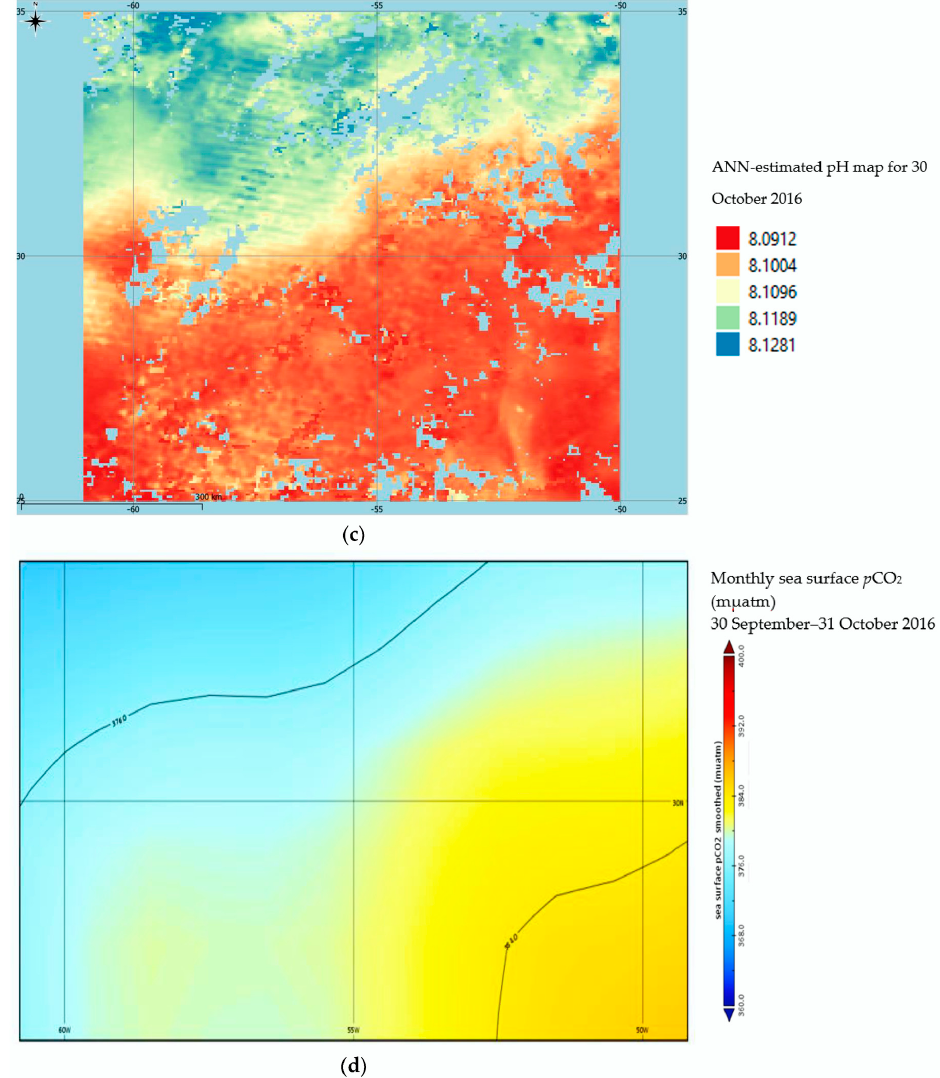
Figure 8. Modeled, gridded ( a ) DIC, ( b ) TA, and ( c ) pH maps for the ROI produced by the ANN algorithm. The spatial resolution is 0.04 ◦ × 0.04 ◦ , which corresponds to the native spatial resolution of some of the predictands. The ( d ) p CO 2 map valid for 30 September until 31 October 2016 has been inserted for reference